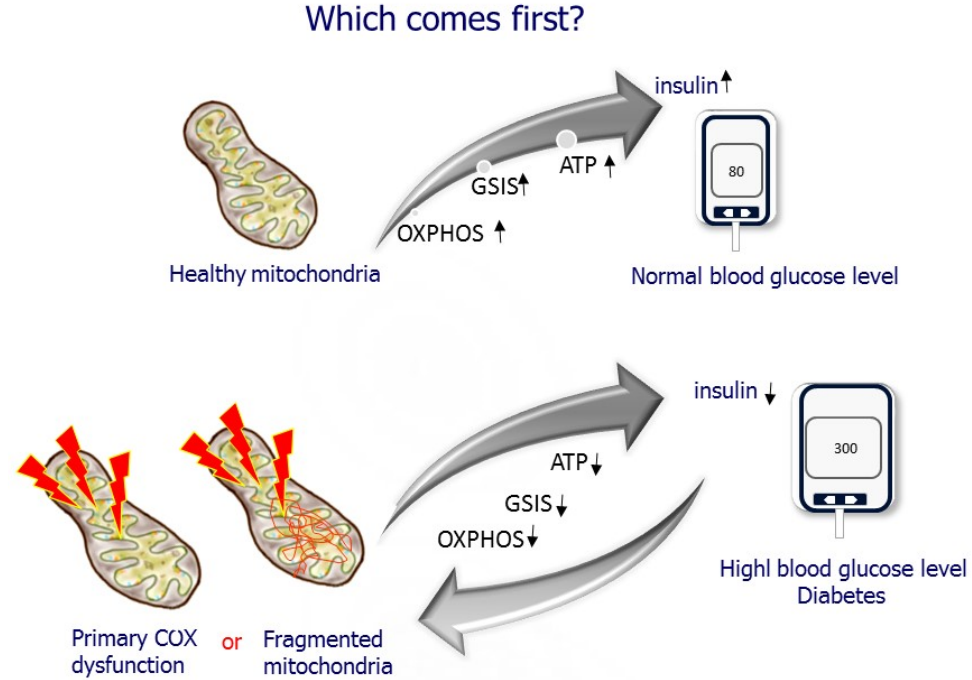
Figure 8. Which comes first? Does mitochondrial dysfunction cause diabetes, or does diabetes hamper mitochondrial function?